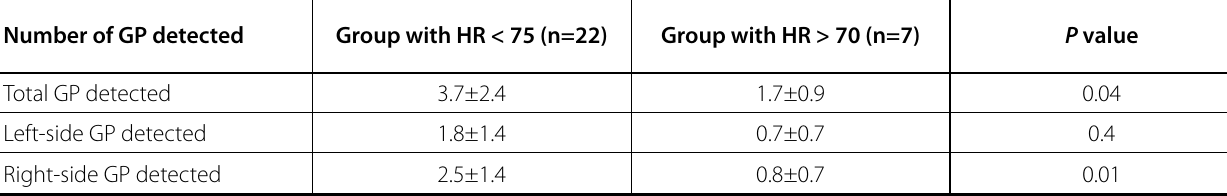
Table 5. Comparison of the average number of GP detected in relation to preoperative heart rate in patients with successful GP detection.